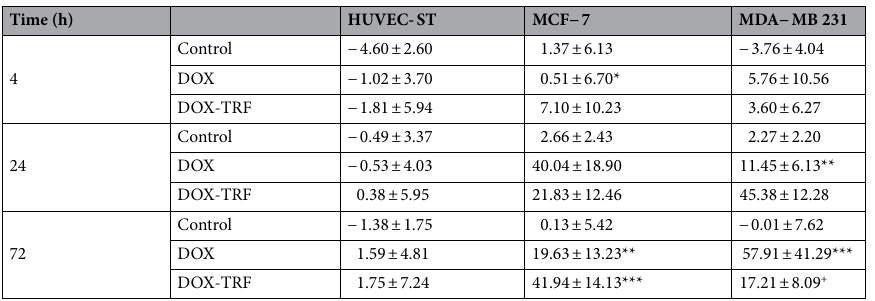
Table 1. Integrity of the inner mitochondrial membrane that refers to the cytochrome c leakage in MCF-7, MDA-MB-231 and HUVEC-ST cell lines after exposure to IC 50 concentrations of DOX or DOX–Tf conjugate. Data are expressed as the percentage values and shown as mean ± SD, n = 3. * p < 0.05, ** p < 0.01, *** p < 0.001 denote a significant difference compared to the respective untreated cells, and + p < 0.05, ++ p < 0.01, +++ p < 0.001 denote significant differences between samples incubated with DOX or